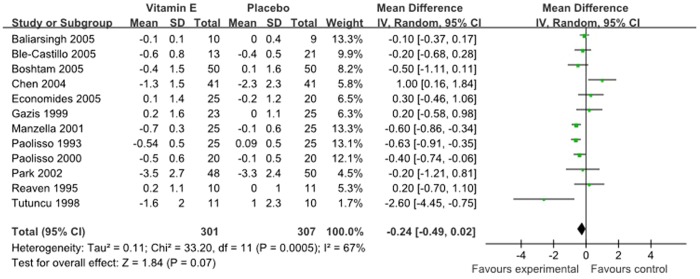
Forest plot of randomised controlled trials investigate the effect of vitamin E supplementation on HbA1c.